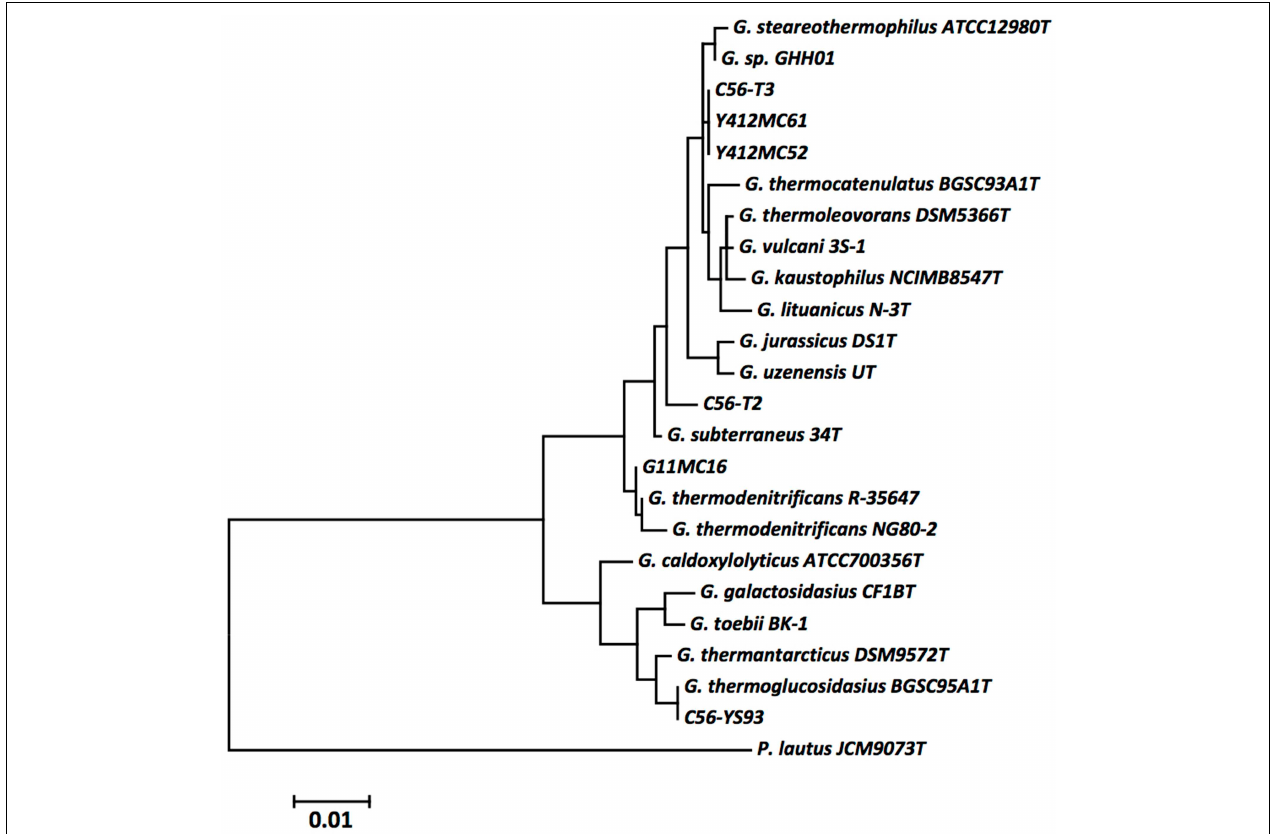
FIGURE 1 | The evolutionary history was inferred by using the Maximum Likelihood method based on the Tamura-Nei model (Tamura and Nei, 1993). The tree with the highest log likelihood ( − 3118.4467) is shown. Initial tree(s) for the heuristic search were obtained automatically by applying Neighbor-Join and BioNJ algorithms to a matrix of pairwise distances estimated using the Maximum Composite Likelihood (MCL) approach, and then selecting the topology with superior log likelihood value. The tree is drawn to scale, with branch lengths measured in the number of substitutions per site. The analysis involved 24 nucleotide sequences. All positions containing gaps and missing data were eliminated. There were a total of 1260 positions in the final dataset. Evolutionary analyses were conducted in MEGA5